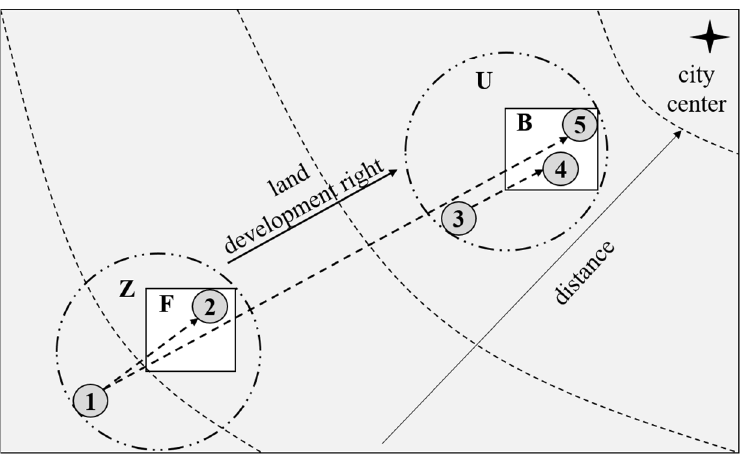
Figure 1. CLR and the transfer of land development